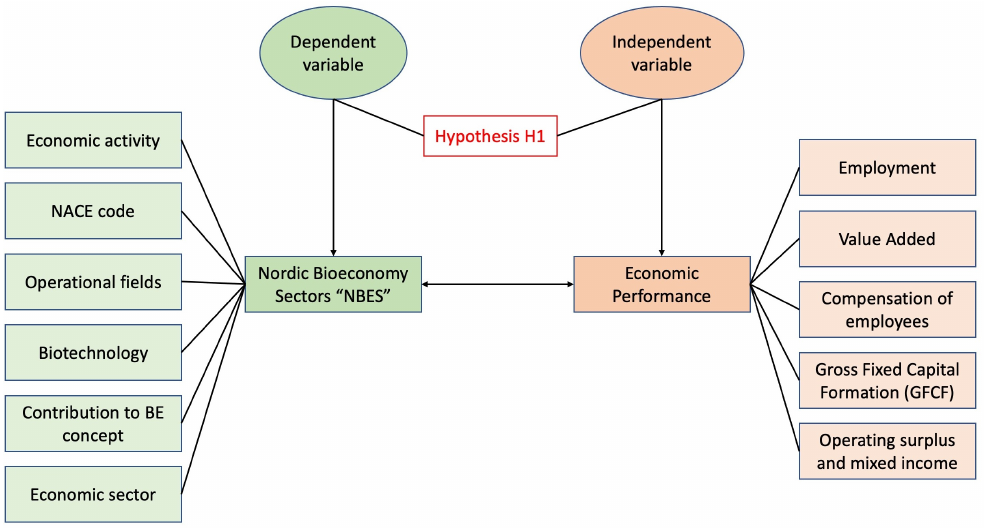
Figure 1. Diagram illustrates Hypothesis (H1) of this research